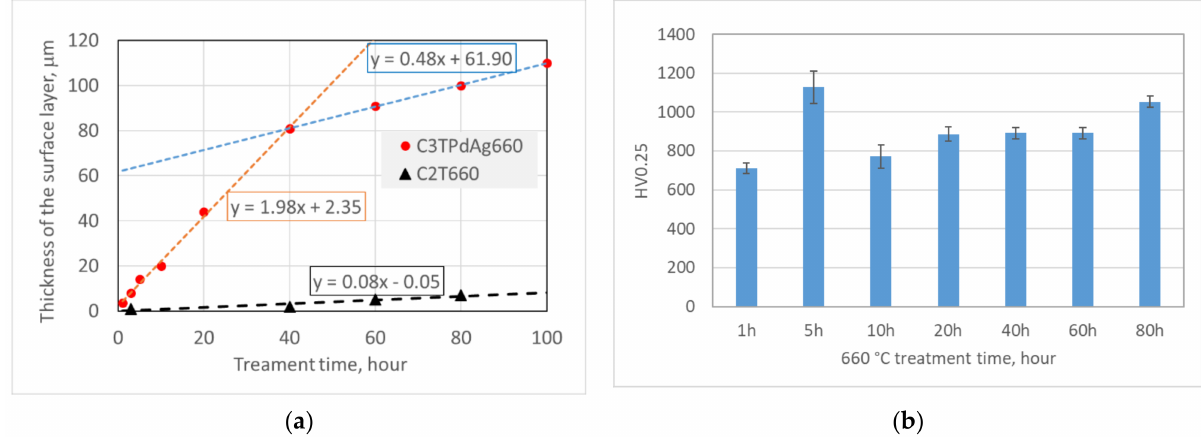
Figure 2. Surface layer ( a ) thickness of C3TPdAg660 and C2T660 samples and ( b ) hardness of C3TPdAg samples treated at 660 ◦ C for different time